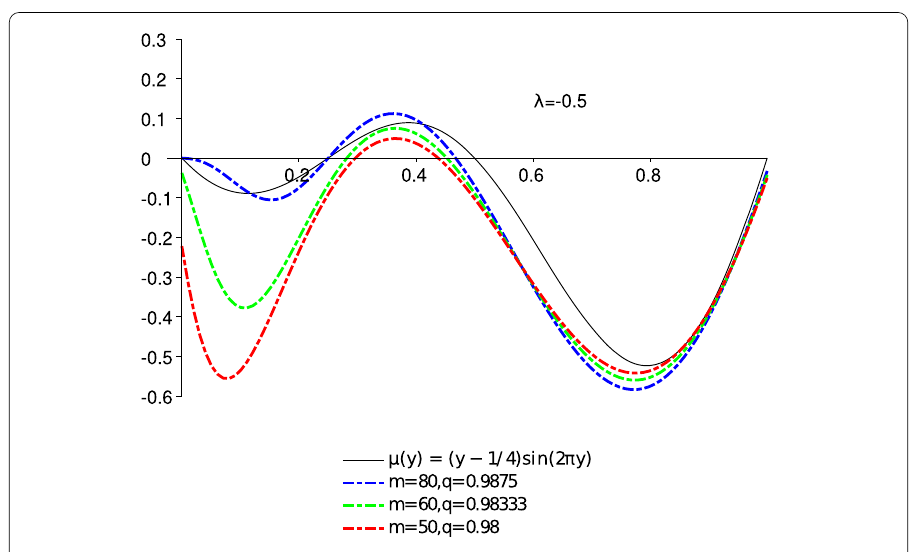
Figure 5 The approximation of D –0.5 m , q ( μ ; y ) to μ ( y ) for fixed values of q and